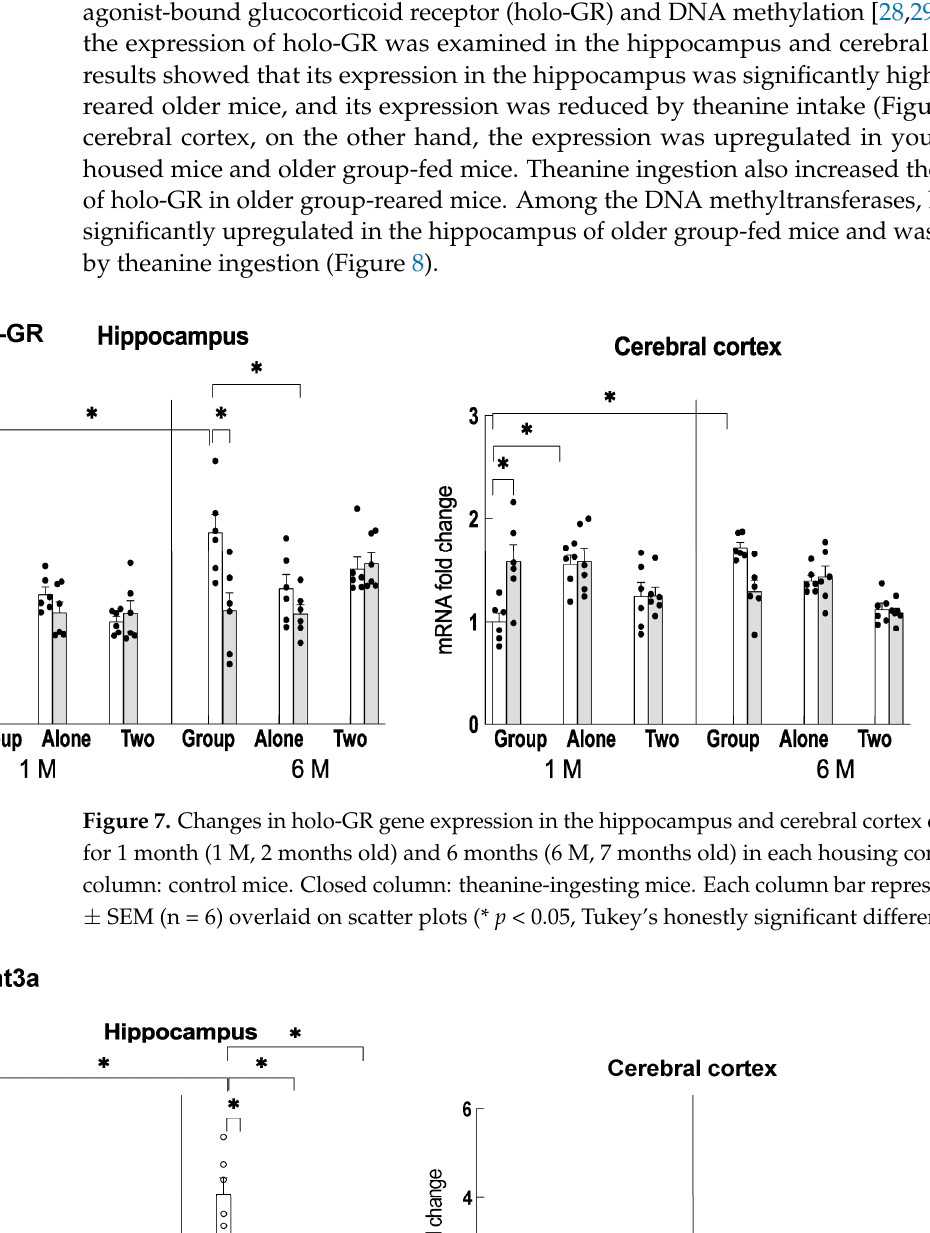
Figure 6. Changes in IEG expression in the hippocampus and cerebral cortex of mice reared for 1 month (1 M, 2 months old) and 6 months (6 M, 7 months old) in each housing condition. Open column: control mice. Closed column: theanine-ingesting mice. Each column bar represents the mean ± SEM (n = 6) overlaid on scatter plots (* p < 0.05, Fisher’s exact probability test).